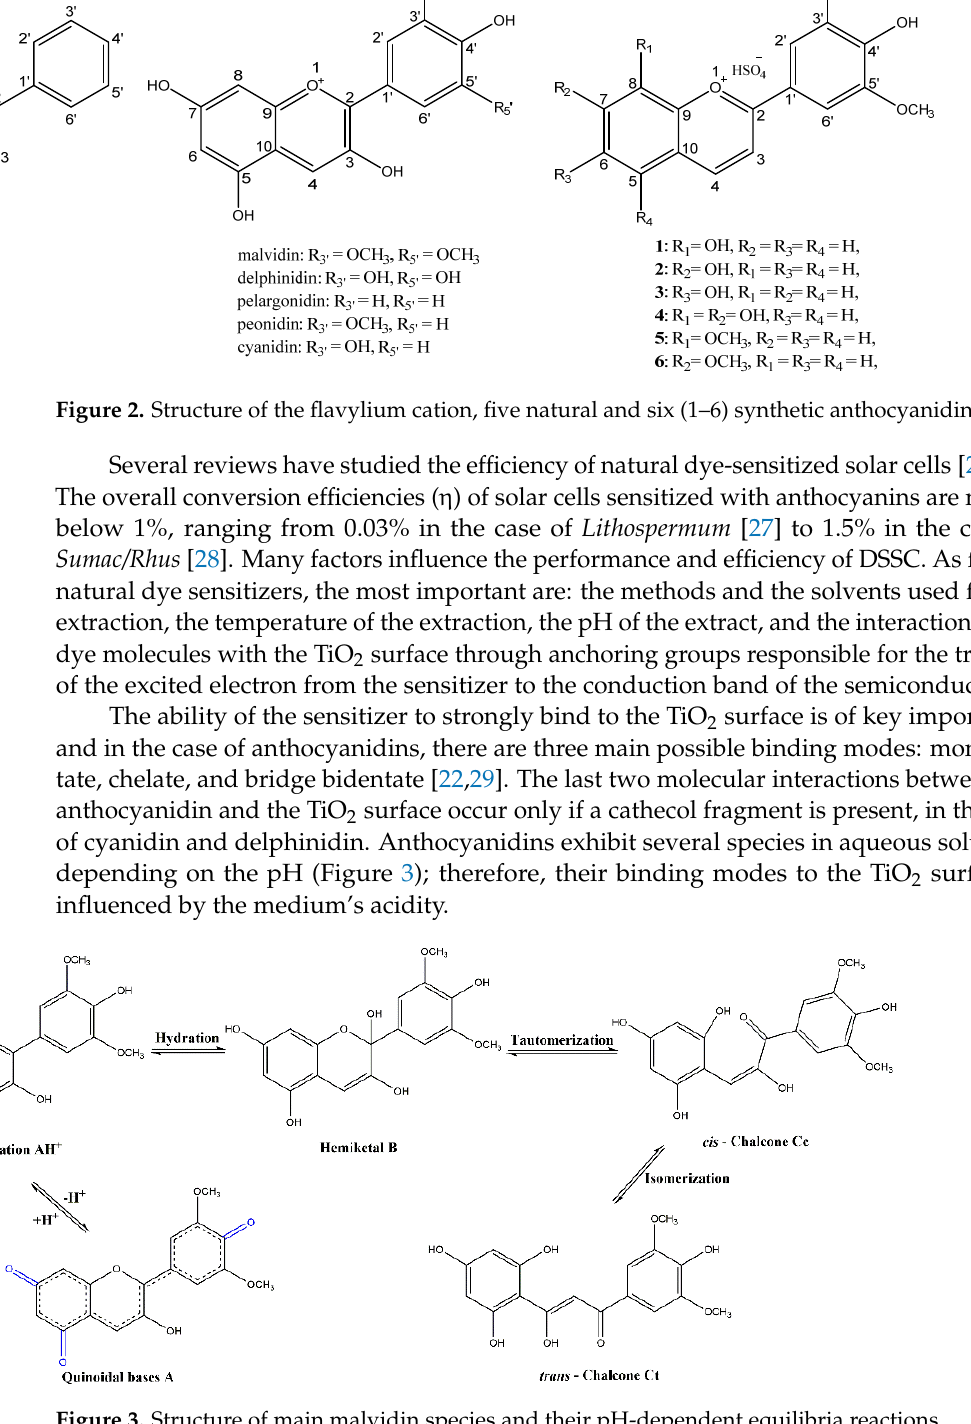
Figure 3. Structure of main malvidin species and their pH-dependent equilibria reactions.